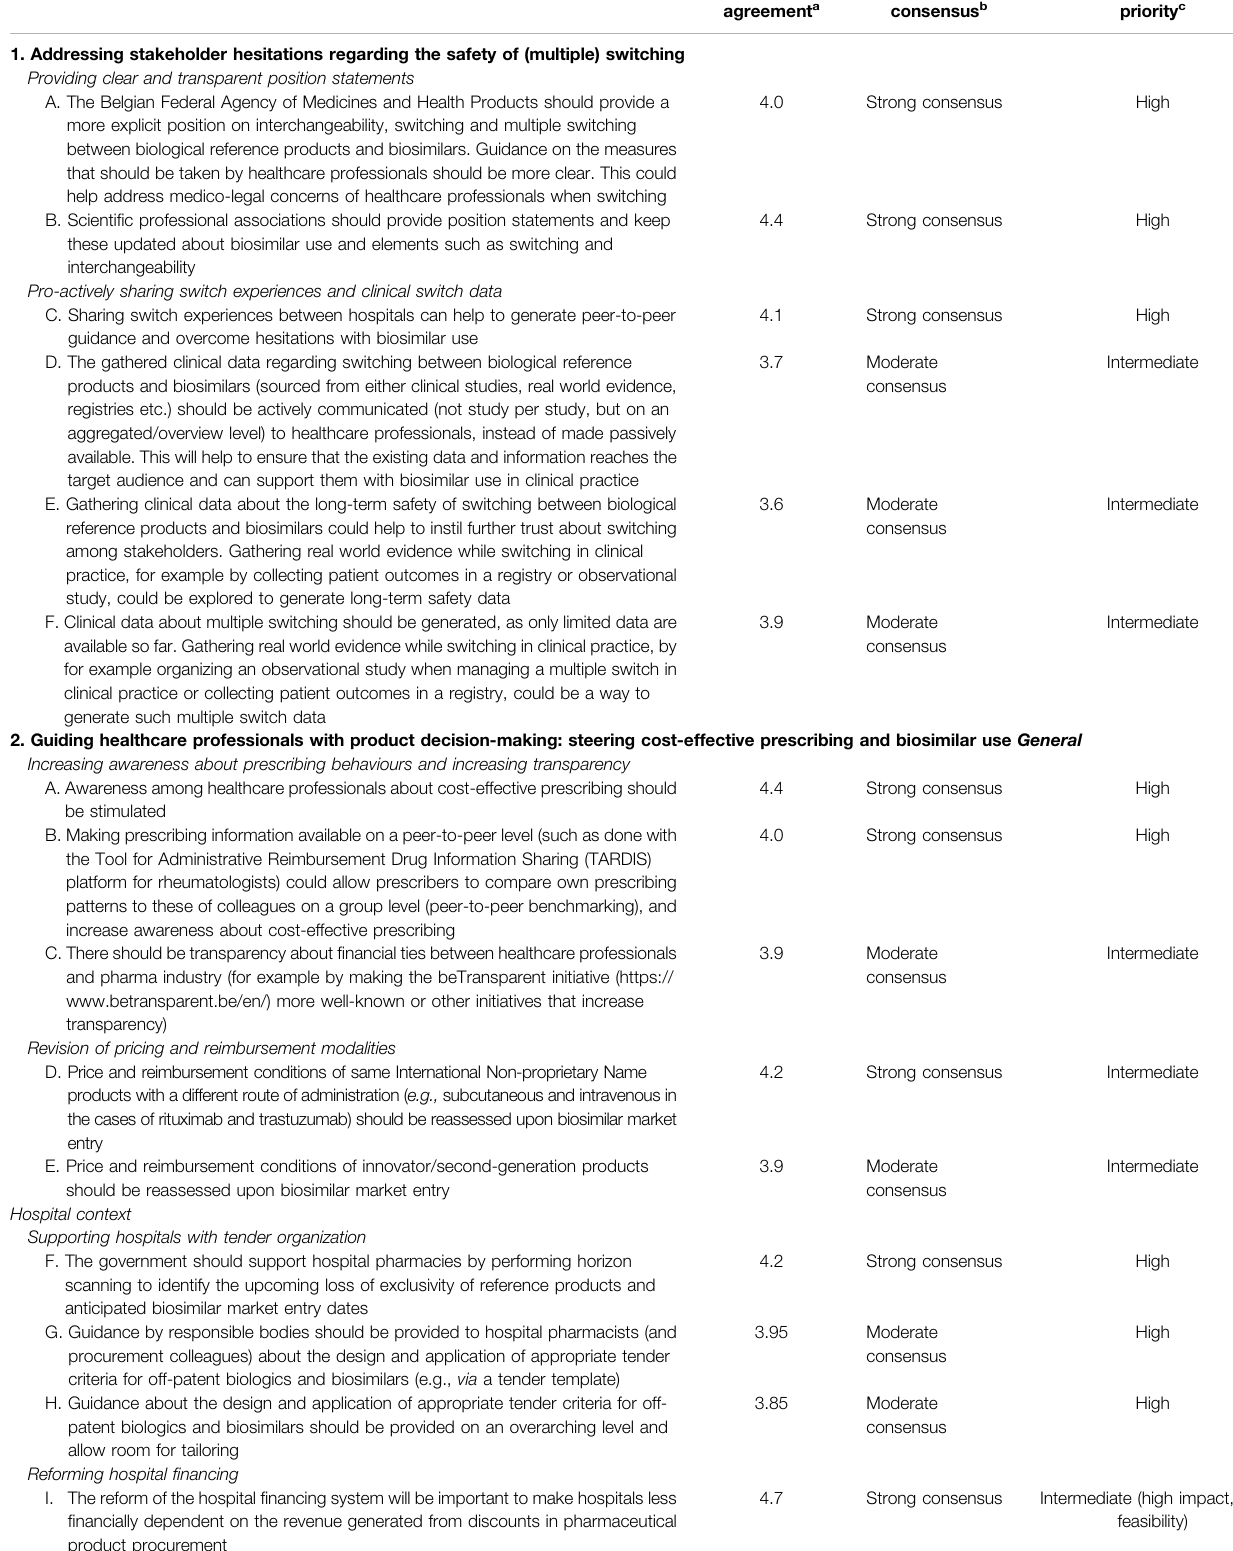
TABLE 2 | Biosimilar use and switch decision-making in Belgium: proposals for policy action from structured healthcare professional group